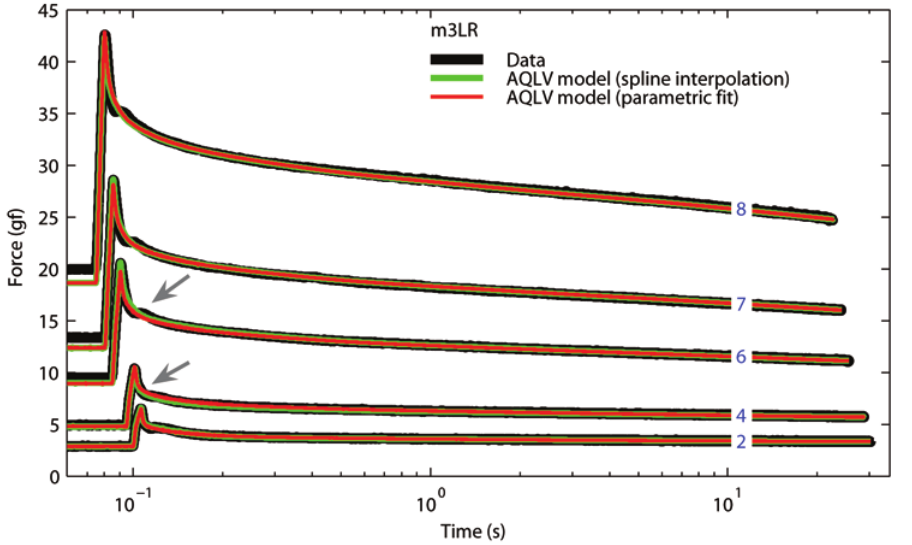
Figure 8. Step responses and AQLV model fits. Data (black) and force predicted by the AQLV model. A four-parameter non-linear equation was used to fit the values for the parameters derived from the QLV model at each step length (red trace). Because this model has fewer degrees of freedom than the cubic spline used in Fig. 6(and shown here in green), the fit is not as good (gray arrows point to the largest discrepancies between the two models), but it is very good nonetheless. Data for the lateral rectus in m3, the muscle for which we obtained the worst fit between model and data. Just as in Fig. 6, the traces are offset in time for clarity.